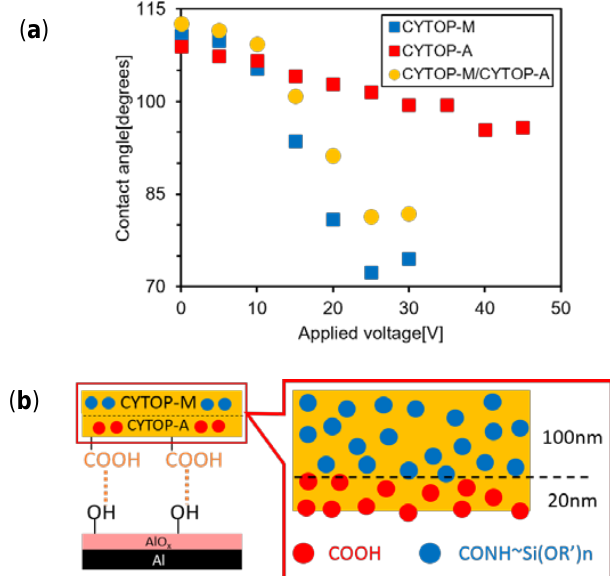
Figure 6. ( a ) EWOD curve of CYTOP-M (blue), CYTOP-A (red), and CYTOP-M / CYTOP-A (yellow). ( b ) The model of stacked CYTOP-M / CYTOP-A / AlO x / Al. The CYTOP / AlO x interface had hydrogen bonding because of lowly placed CYTOP-A with carboxyl groups, and amide groups were included inside a CYTOP layer.